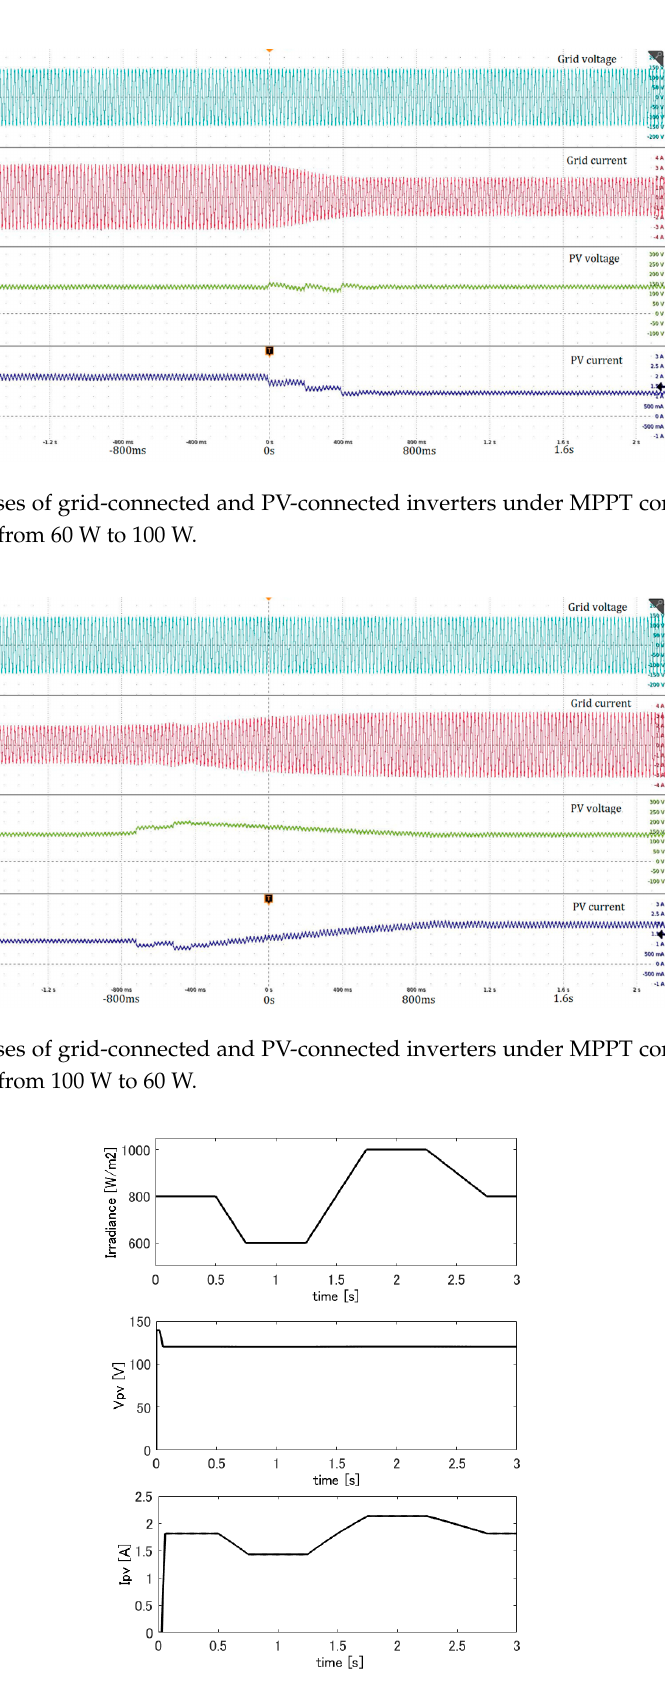
Figure 17. Responses of the P&O control with the varying irradiance.